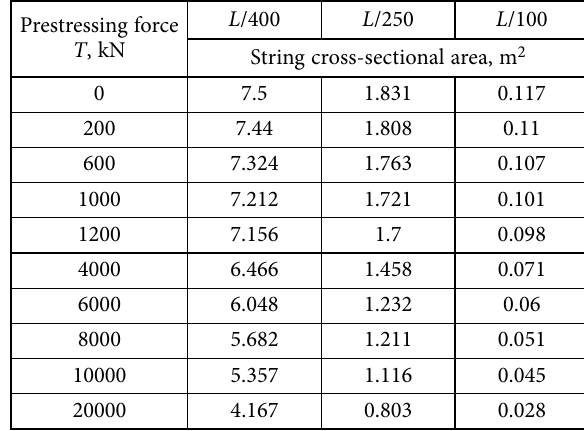
Table 2. Dependence of string cross-section on ultimate deflection and prestress at L = 50 m